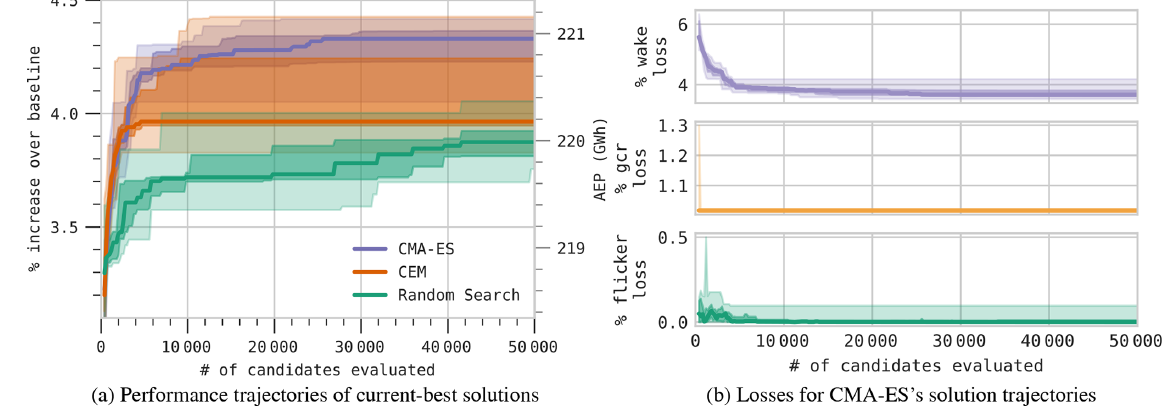
Figure A1. Optimization progress curves on the high-correlation site with an irregular boundary over 10 optimization runs. Dark lines indicate median values as observed over 10 optimization runs. The dark fill around the median spans the 25th–75th percentile range, and the lighter fill spans the minimum to maximum range.